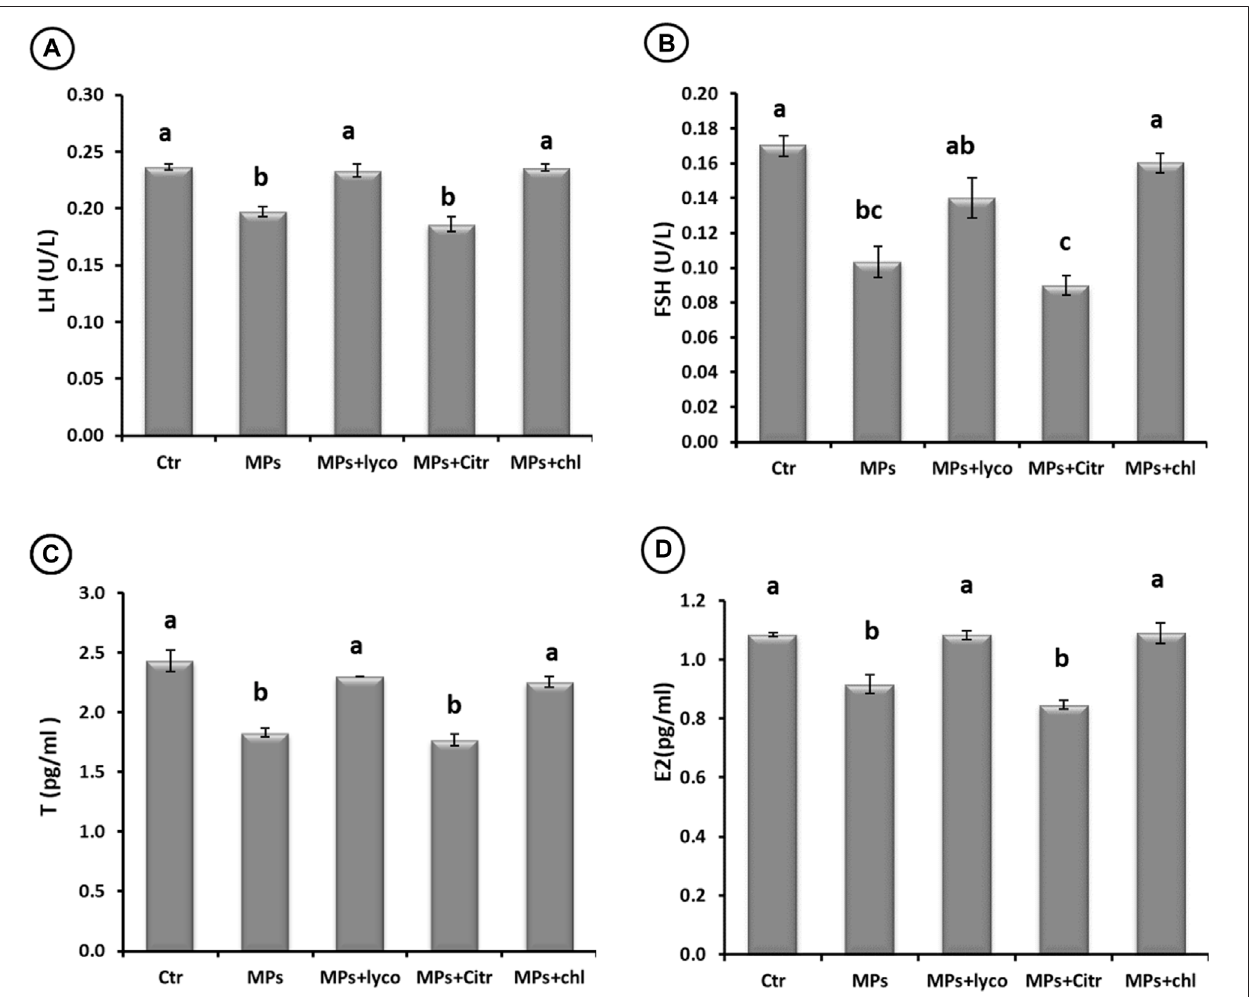
FIGURE 1 | Effect of ingestion of MPs and ameliorative effect of lycopene (lyco), citric acid (Citr), and Chlorella (chl) or 15 days on (A) luteinizing hormone (LH), (B) follicle-stimulating hormone (FSH), (C) testosterone (T), and (D) estradiol (E2) levels of mature maleAfrican cat fi sh ( C. gariepinus ). Dataare demonstrated asmean ± SE, n (cid:1) 6. Bars carrying different superscripts (A – C) are signi fi cantly different at ( p <